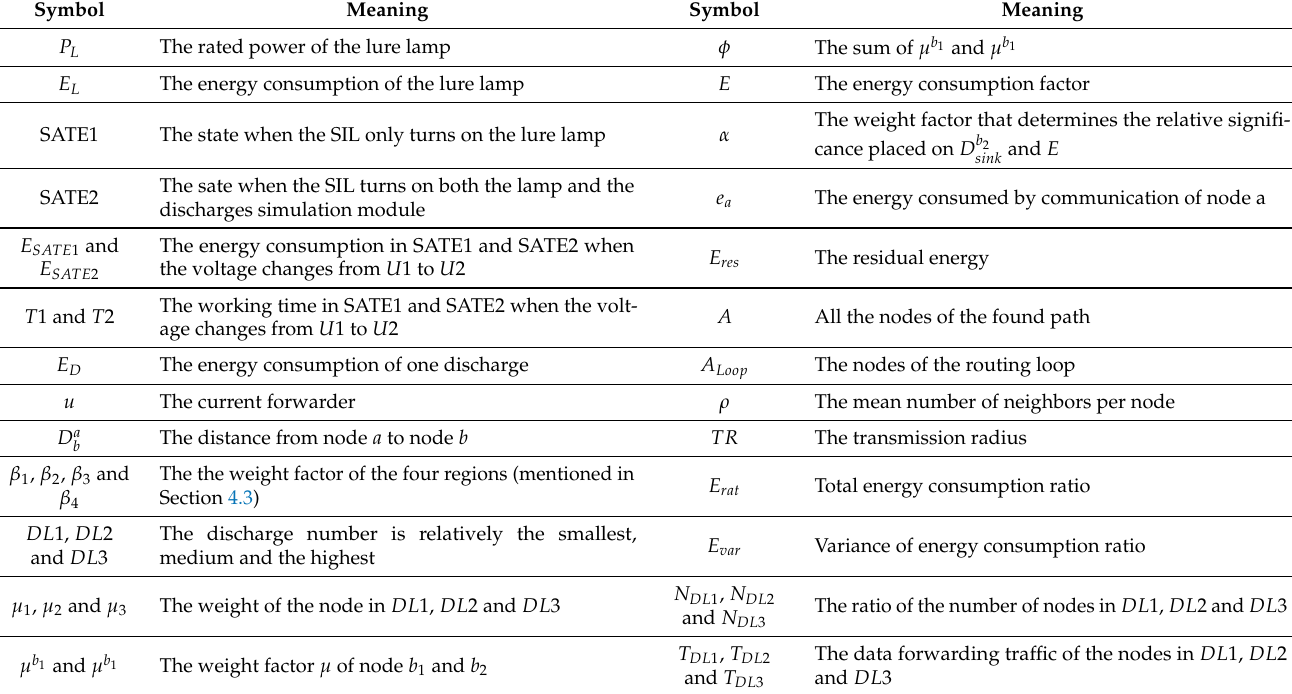
Table 4. The important